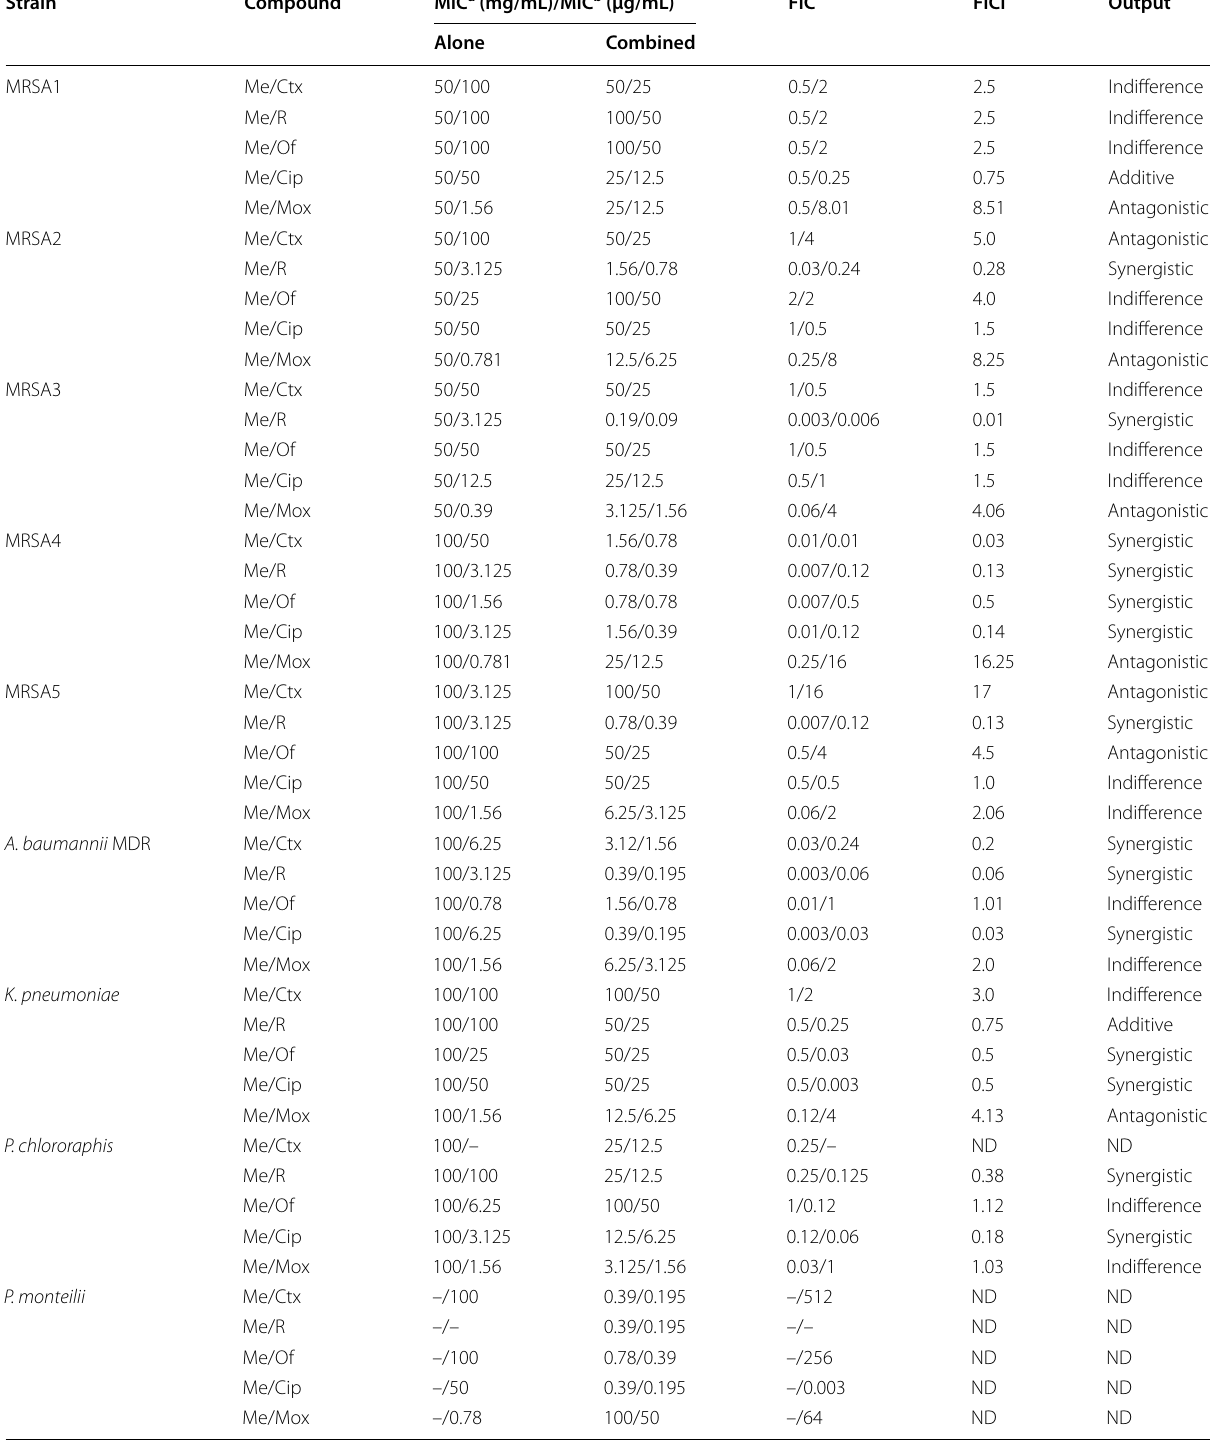
Table 5 Minimum inhibitory concentration (MIC) and fractional inhibitory concentration (FIC) of methanolic extract, each antibiotic alone and their combination against MDR pathogenic bacterial